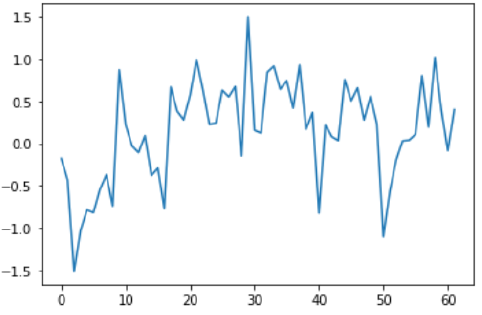
Figure 15. Accelerometer sensor data noise.